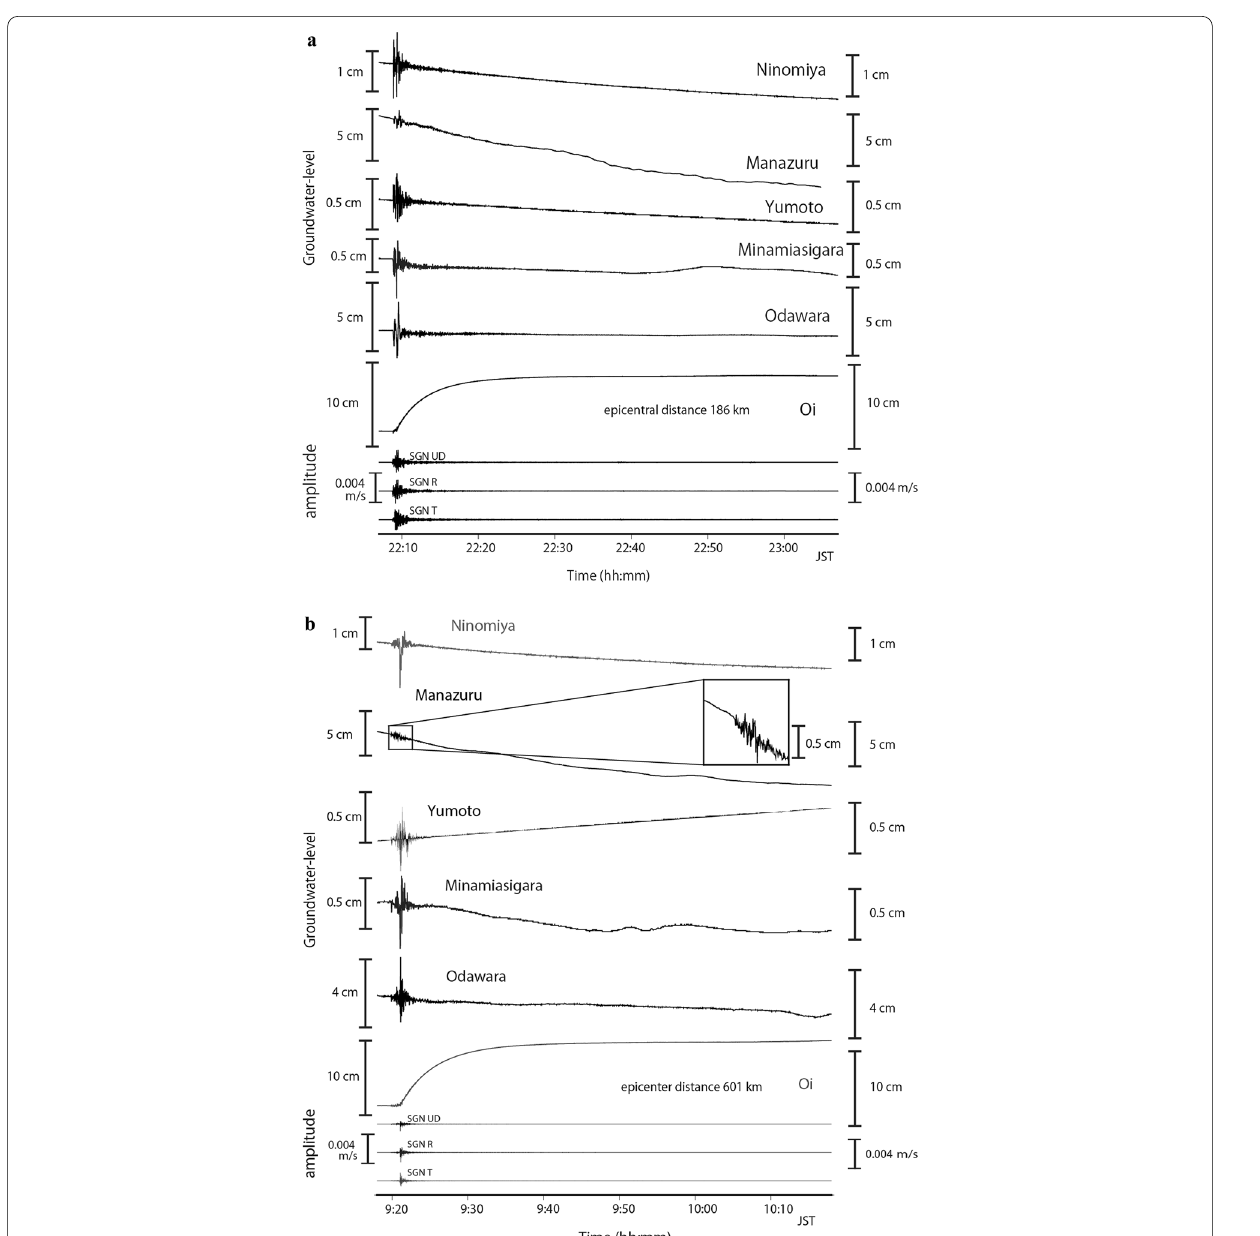
Fig. 2 Groundwater level changes in the six wells of the HSRI observational network for four earthquakes. a Responses to the M6.2 earthquake of November 22, 2014, in the northern Nagano prefecture, central Japan (event 9 in Table 2). The epicentral distance range is from 184 to 201 km. b Responses to the M6.5 earthquake of September 4, 2013, in the Izu Bonin region, southern Japan (event 4 in Table 2). The epicentral distance range is from 579 to 601 km. c Response to the M7.8 earthquake of April 25, 2015 (event 10 in Table 2). The epicentral distance range is from 5133 to 5148 km. The vertical line indicates the arrival time of Rayleigh waves identified on the seismograms. The propagation velocity is approximately 3.25 km/s, which is in agreement with the group velocities of Rayleigh waves with oscillation period of 30 s along the propagation path in and around China (Feng and An 2010). d Response to the M9.1 earthquake of March 11, 2011 near the east coast of Honshu, Japan (event 1 in Table 2). The epicentral distance range is from 433 to 453